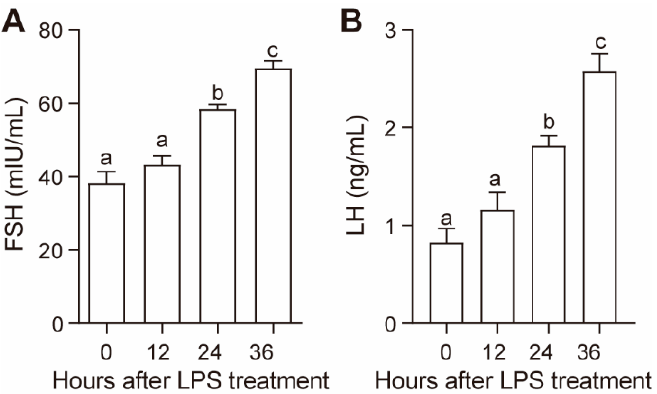
Figure 1. Effect of lipopolysaccharide (LPS) on plasma follicle stimulating hormone (FSH) ( A ) and luteinizing hormone (LH) ( B ) concentrations. Values with different letters are significantly different ( p < 0.05).